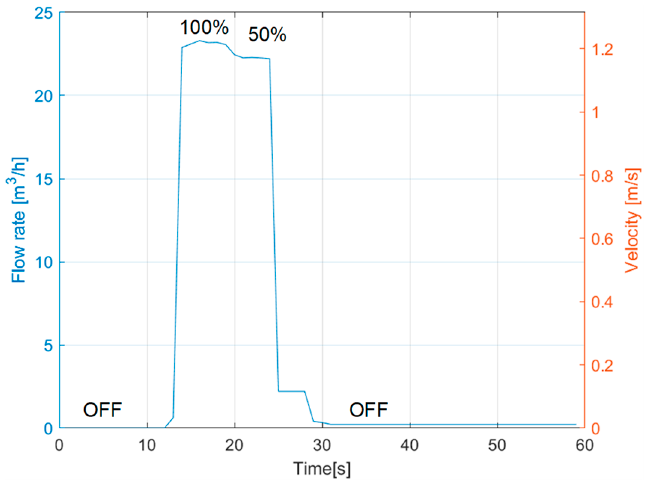
Figure 5. Ultrasonic measurement of water flow rate in the loop.